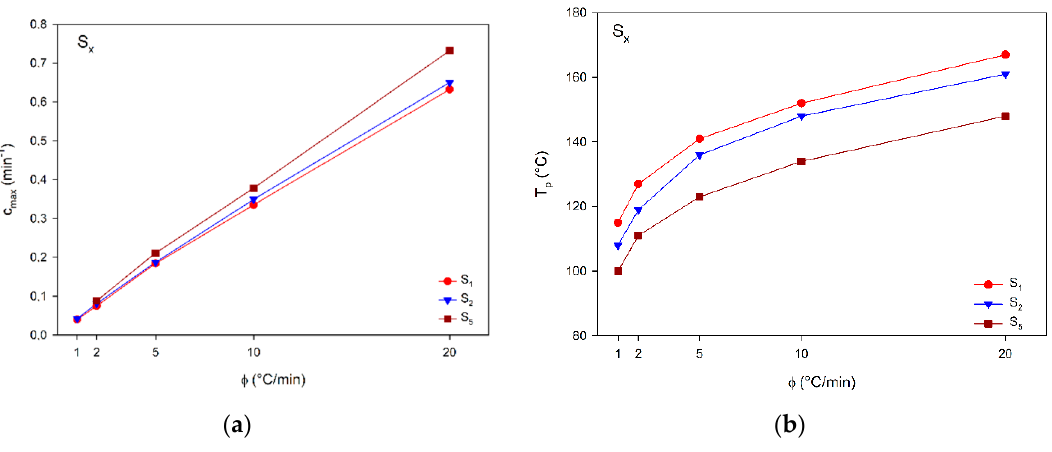
Figure 4. Effect of heating rates and DEH 35 content on ( a ) c max (min − 1 ) and ( b ) T p (°C). Benchmark compounds. Table 4. Cure parameters of benchmark compounds computed from DSC scans.